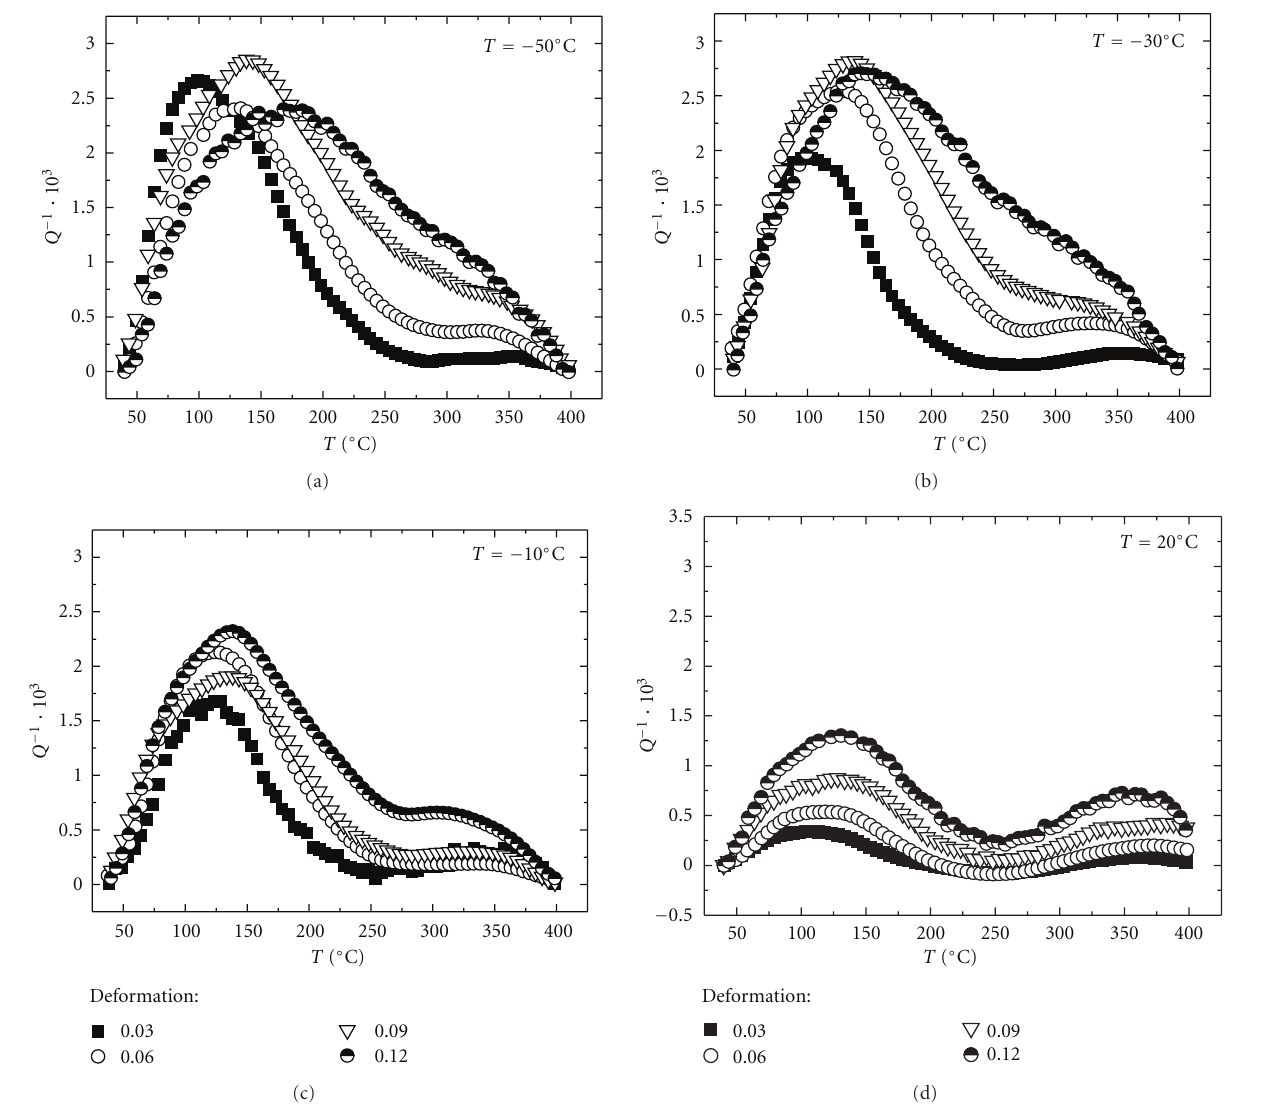
Figure 5: Internal friction spectra of samples with previous tensile true strain from 0.03, 0.06, 0.09 and 0.12 introduced at the following temperatures; (a) − 50 ◦ C, (b) − 30 ◦ C, (c) − 10 ◦ C and (d) 20 ◦